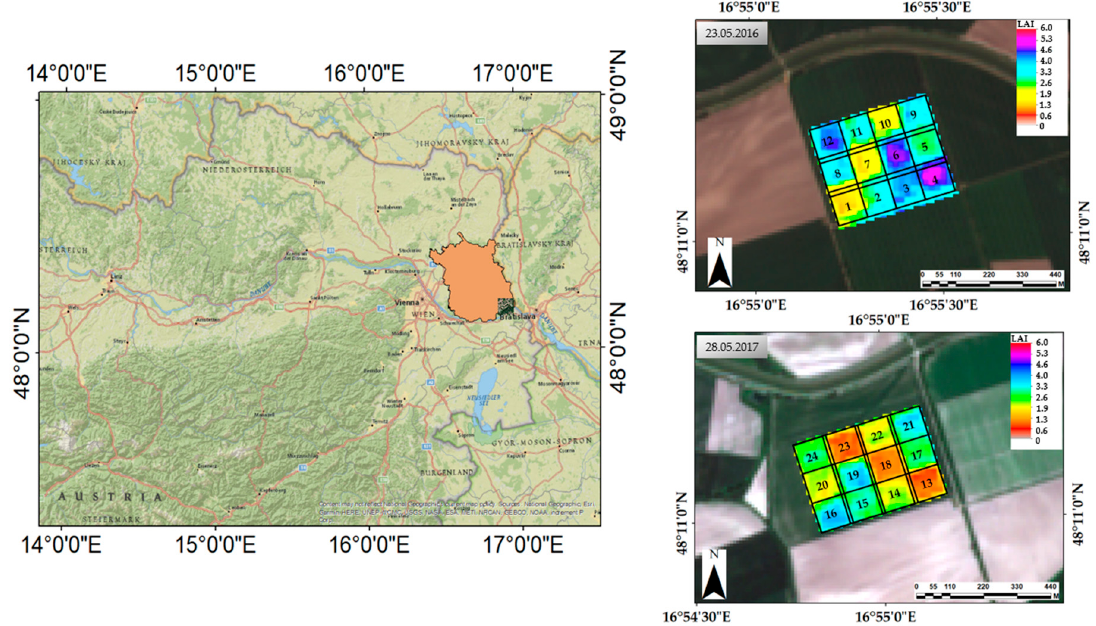
Figure 1. Study area of Marchfeld (left), Lower Austria, and the experimental plots in 2016 (top right) and 2017 (bottom right). It is possible to notice the variability in LAI values as a result of different fertilization rates given during the growing cycle.